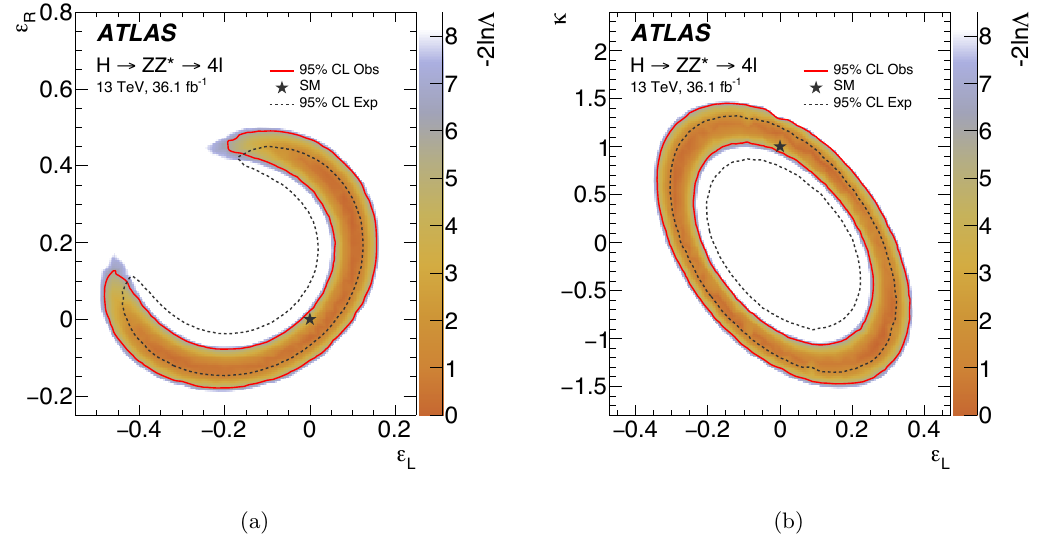
Figure 11. Limits on modi(cid:12)ed Higgs boson decays within the framework of pseudo-observables [15, 81]. In (a), the limits are extracted in the plane of " L and " R , which modify the contact terms between the Higgs boson and left- and right-handed leptons, assuming lepton-(cid:13)avour universality. In (b), the tested parameters are " L and (cid:20) . The latter modi(cid:12)es the coupling of the Higgs boson to Z bosons. The allowed observed area at the 95% CL is surrounded by the red solid line. This can be compared to the SM prediction, which is indicated by the black star and the black dotted line. The coloured scale indicates the values of (cid:0) 2 ln